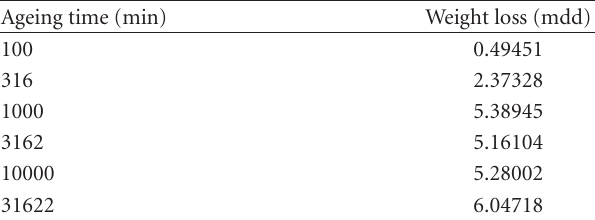
Figure 5: Dissolution of the secondary austenite in weight loss test (black: attacked region in the secondary austenite phase adjacent to the sigma phase, gray: austenite, and white: